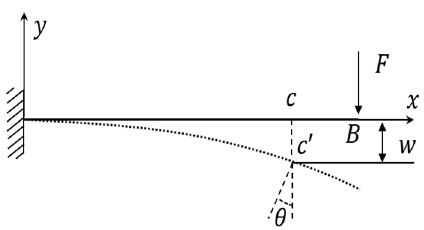
Figure 9. The simplified model of the steel pipe pile.